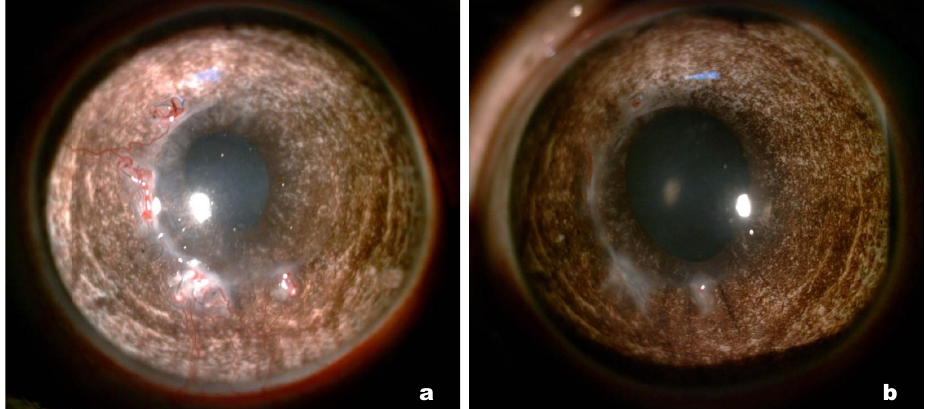
Figure 4. The role of sutures in corneal neovascularization. ( a ) Rabbit cornea with implanted membrane 6 months after surgery (before suture removal); ( b ) same cornea after removal of the sutures (1 week later).